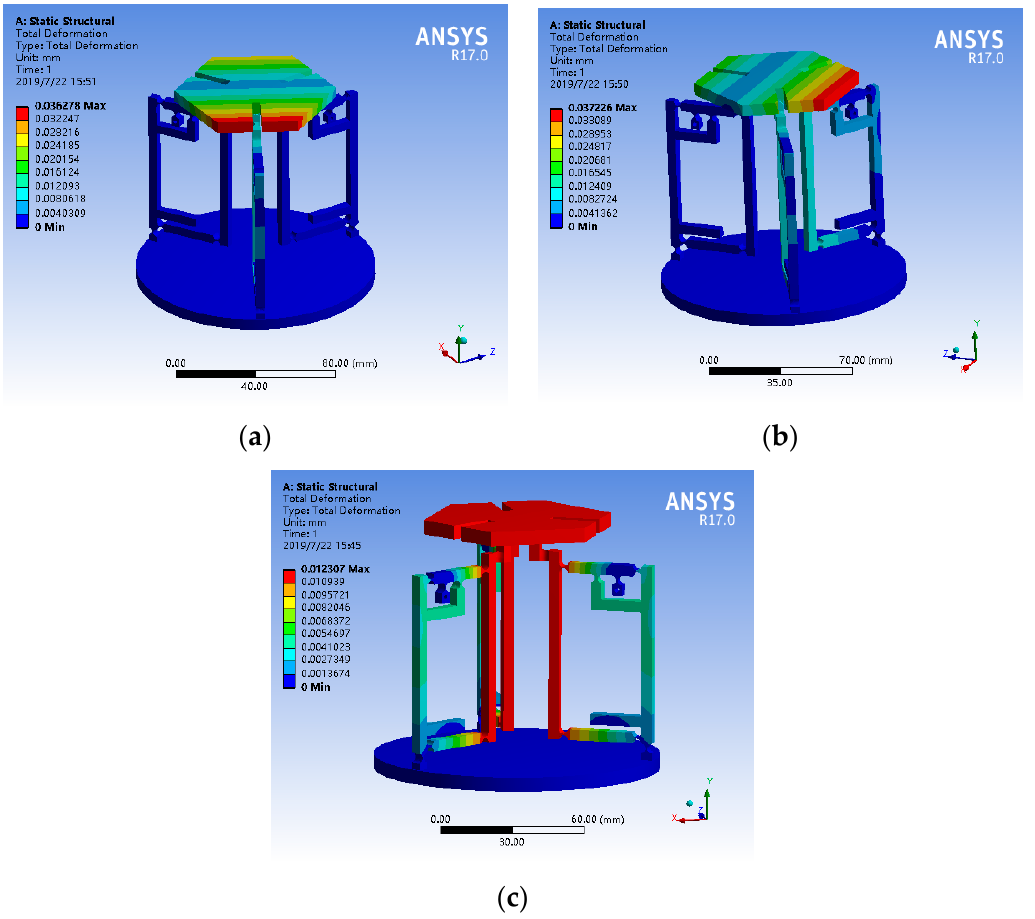
Figure 7. Simulation of amplifier mechanism. ( a ) One-branch was loaded displacement of 5 μ m. ( b ) Two-branch were loaded with displacement of 5 μ m. ( c ) Three-branch were loaded with displacement of 5 μ m.